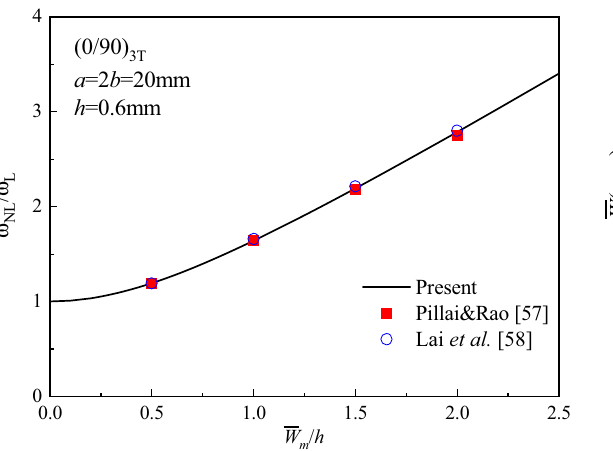
Figure 6: Comparison of load – de fl ection relationships of [ 45 C / − 45 F ]